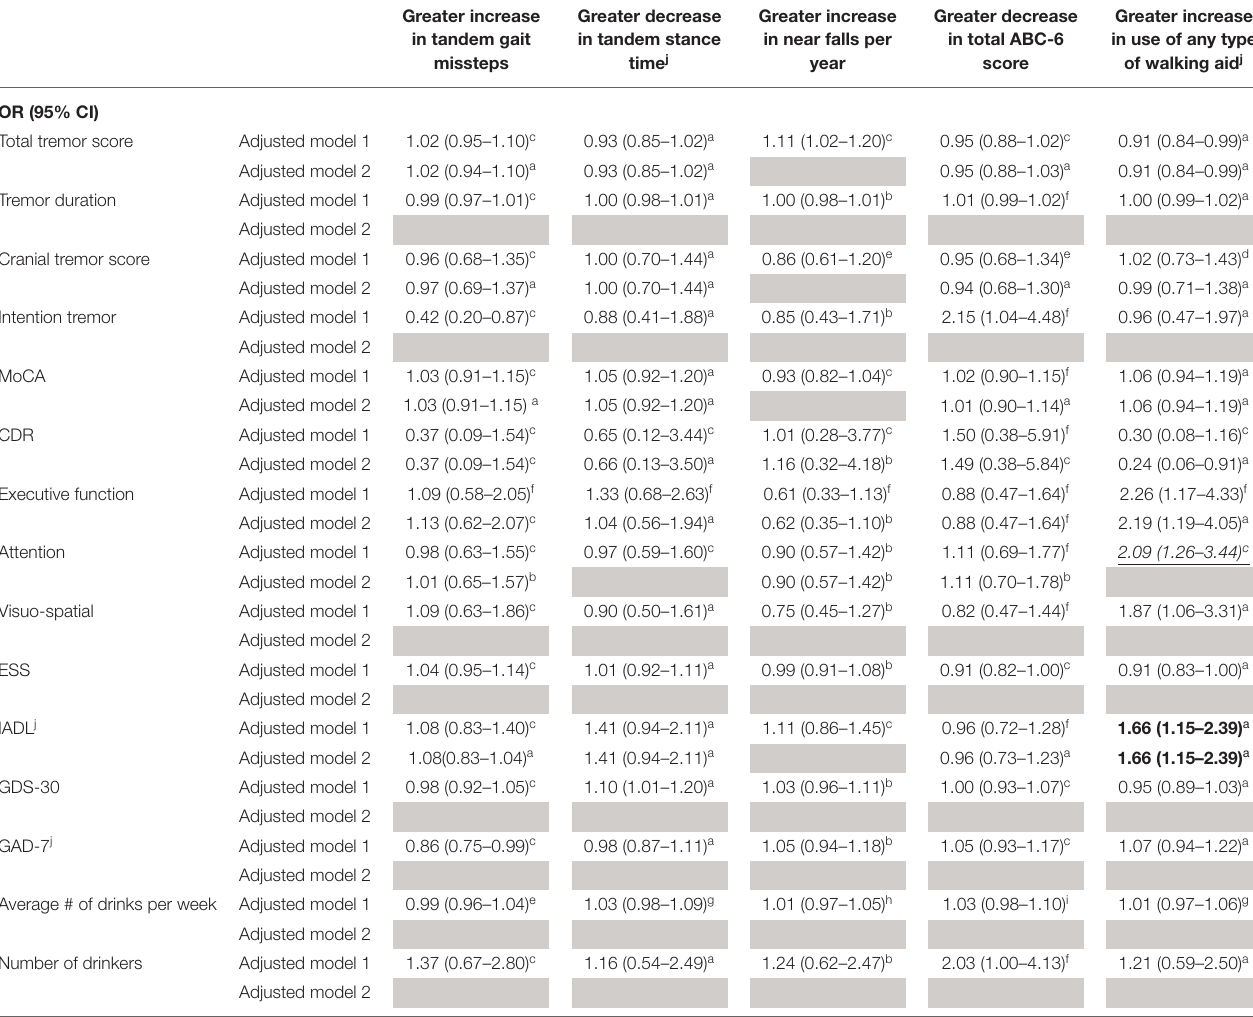
TABLE 4B | Adjusted logistic regression models: Baseline characteristics as predictors of change in gait and balance outcomes.